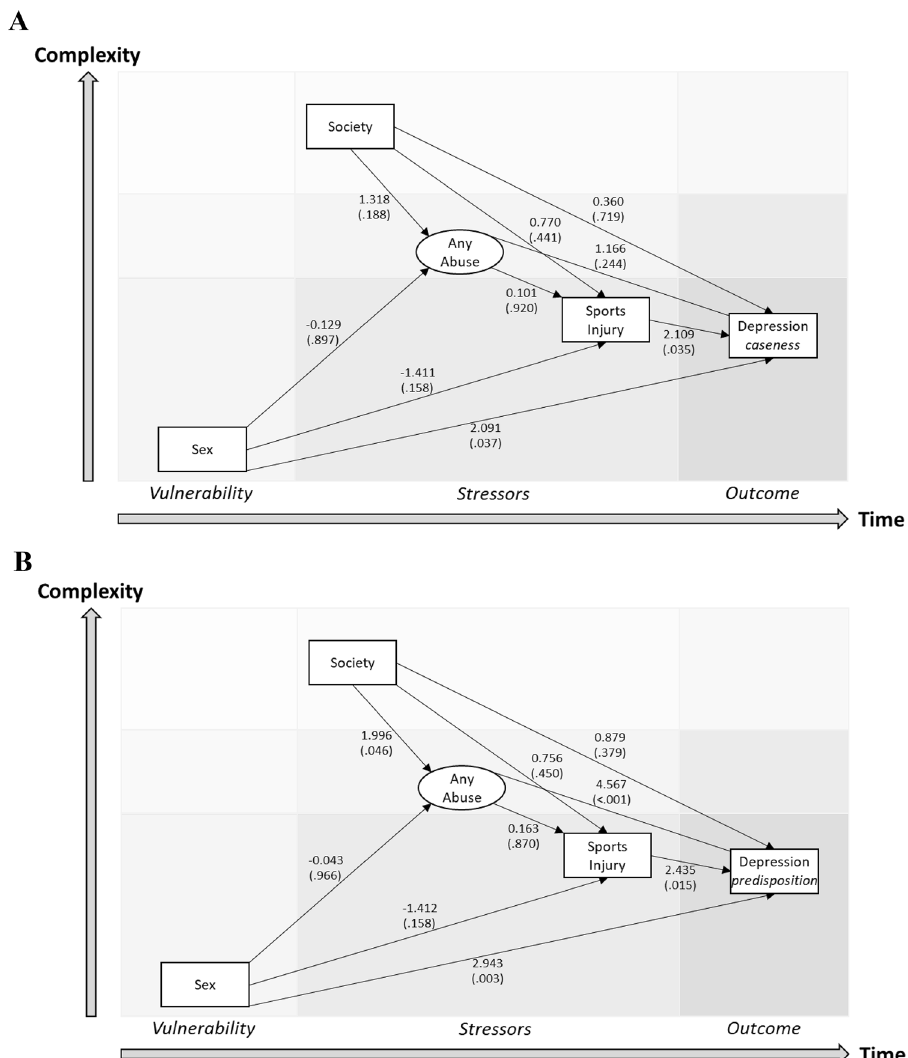
Figure 1. Diathesis-stress models of depression etiology in young sportspersons where abuse is represented by any lifetime abuse (either lifetime sexual or physical abuse). Models of ( A ) depression caseness (WHO-5 score < 50), and ( B ) predisposition to depression (crude WHO-5 score) are